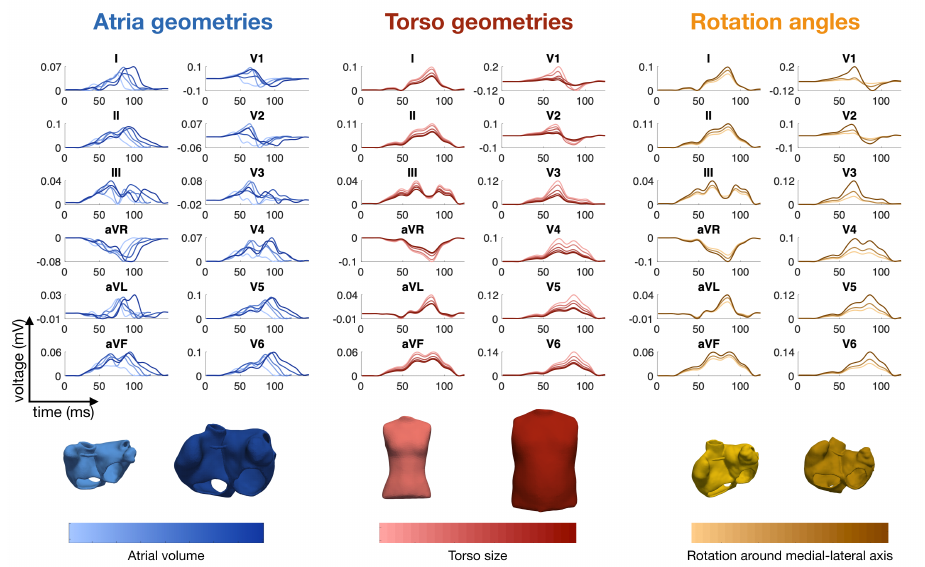
Figure 1. Simulated P-waves of the 12-lead ECG with various atrial shapes, several orientations of the atria inside the torso and a variety of body shapes. The colors represent the total atrial volume in blue, the torso size in red and the orientation angle around the medial-lateral axis in orange